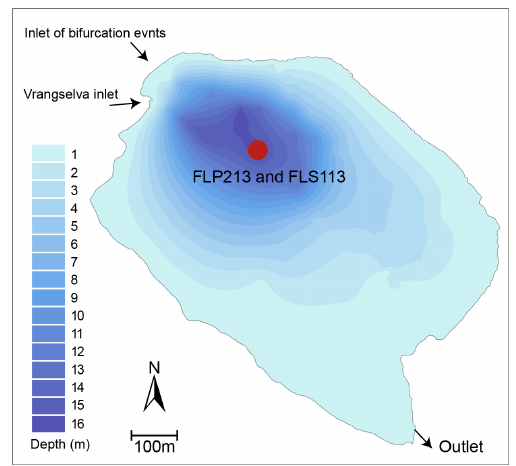
Figure 5. Bathymetric map of Lake Flyginnsjøen and the coring sites which were chosen at the deepest part of the lake, close to the inlet. Note that the inlet during bifurcation events is only around 30m away from the permanent